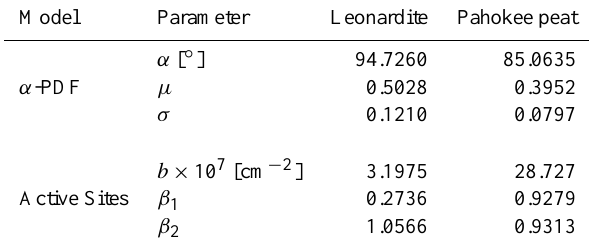
Table 5. Fit parameters for α -PDF and active sites descriptions when fitting entire immersion freezing data sets including all inves- tigated water activities for water and aqueous ammonium sulfate droplets containing leonardite and Pahokee